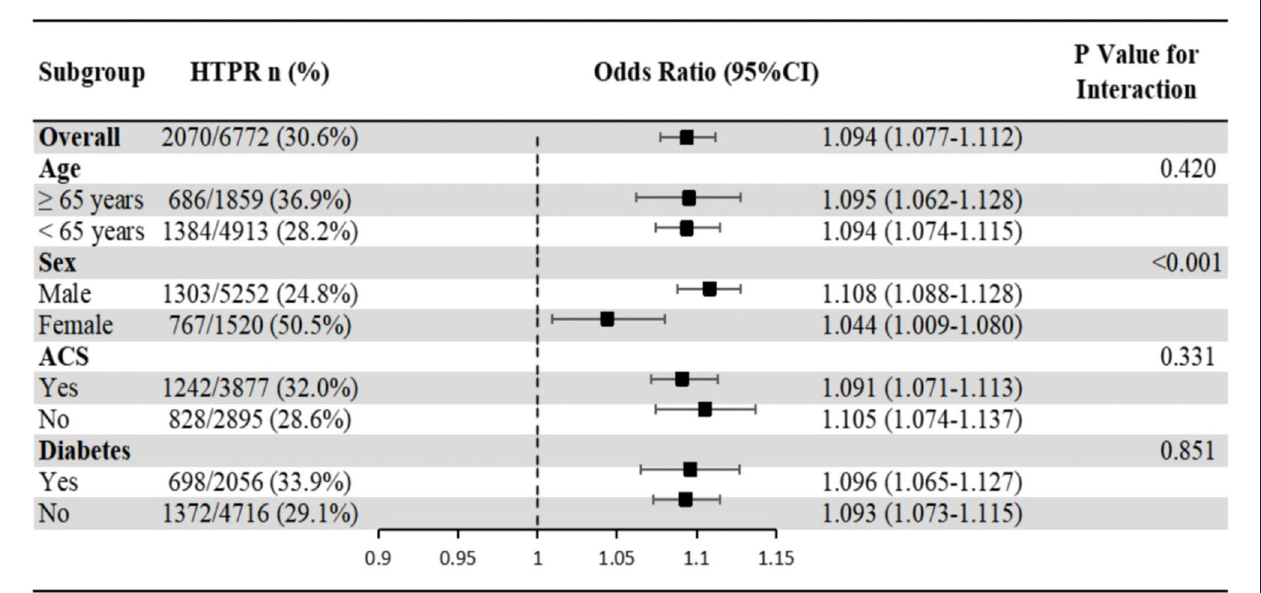
FIGURE 4 | Subgroup analyses of the association of hs-CRP with HTPR. Odds ratios and 95% confidence intervals are shown for HTPR. P -value represents interaction test between the variable and hs-CRP. ACS, acute coronary syndrome; HTPR, high on-treatment platelet reactivity; hs-CRP, high-sensitivity C reactive